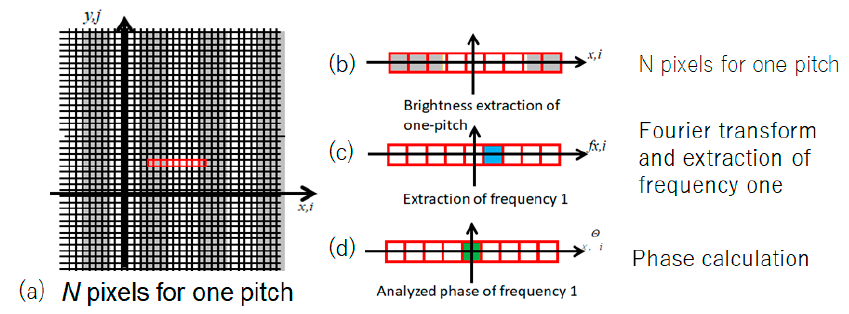
Figure 5. Procedures for OPPA1 [17].